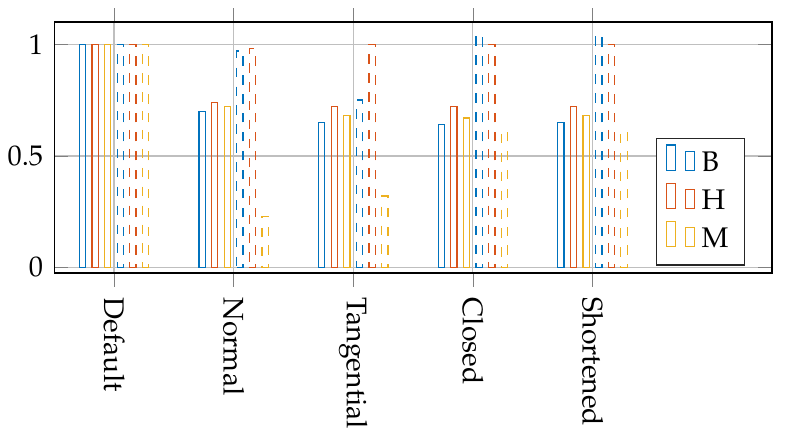
for the rotating machine. Solid bars indicate the averaged fractional values and the dashed bars indicate the maximum fractional values, both also tabulated in Table 6.